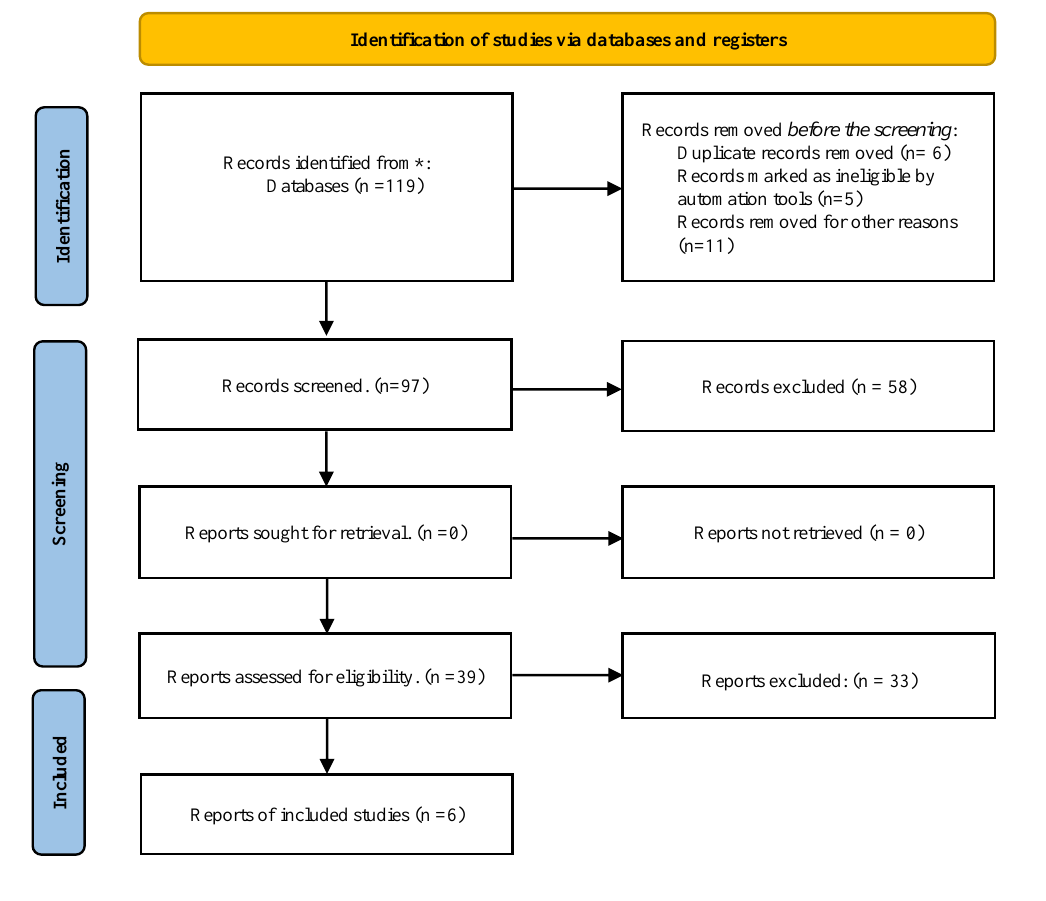
Figure 1. PRISMA 2020 Checklist.